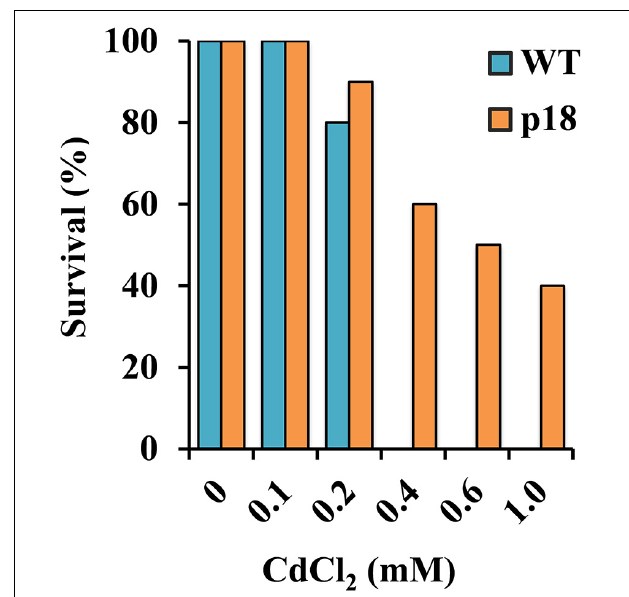
FIGURE 3 | Survival percentage of WT and p18 plants upon exposure to different CdCl 2 concentrations ( n = 30). The germination percentages were analyzed by Pearson’s Chi-squared test ( χ 2) ( p <